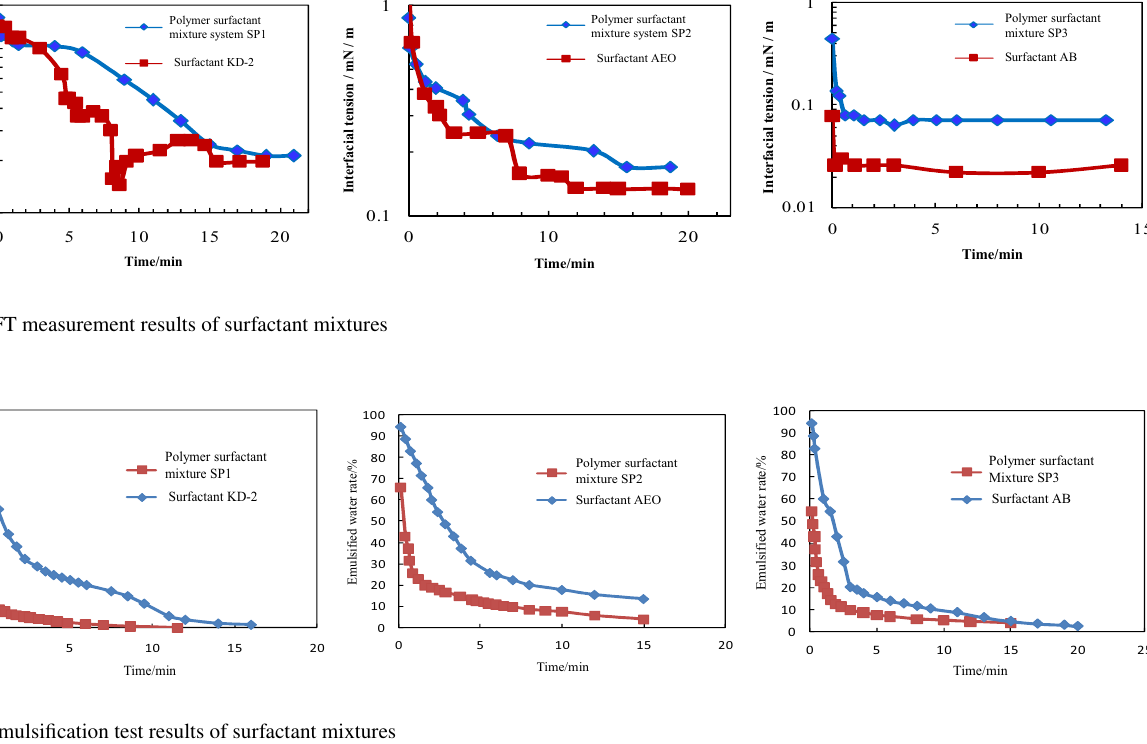
Fig. 7 Emulsification test results of surfactant